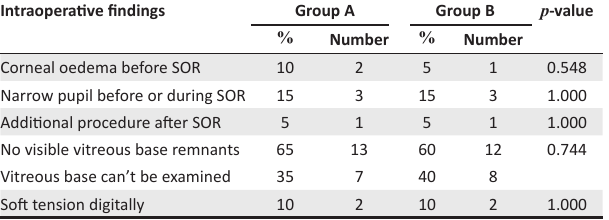
TABLE 4: Second procedure operative data: Silicone oil removal Group A versus silicone oil removal Group B.